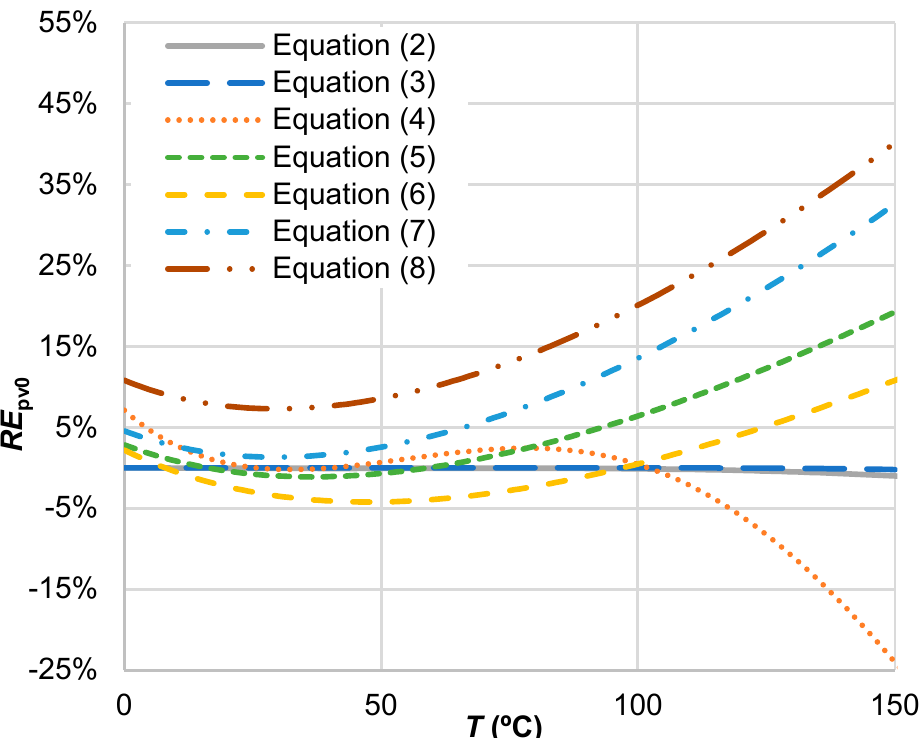
Figure 2. Relative error in the saturated water vapour pressure, RE pv0 , with respect to the ref- erence, Equation (1) [4], as a function of temperature for the different formulations analysed. Equations (2)–(8)